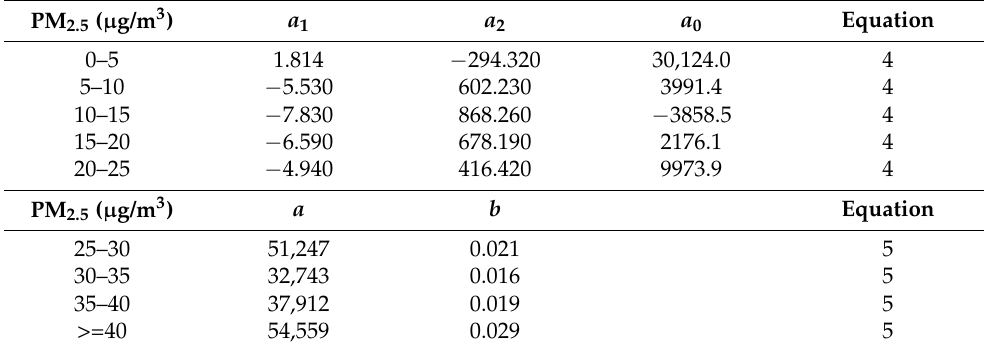
Table 2. Estimation of the coefficients of the predictor variables between visibility (m) and RH (%). PM 2.5 ( µ g/m 3 )